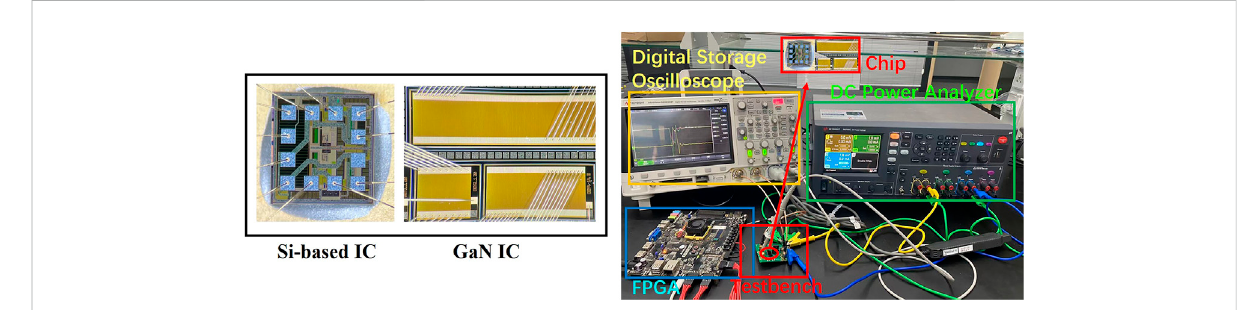
Chip micrograph (left) and Testbench of the proposed driver circuit (right).